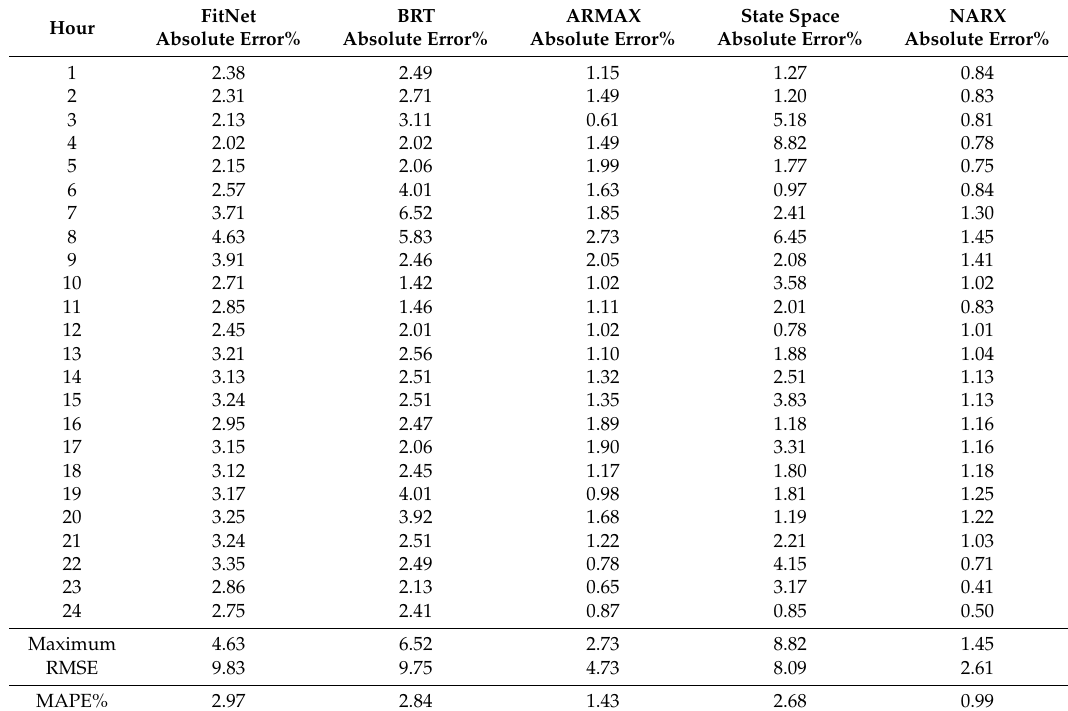
Table 1. Model comparison